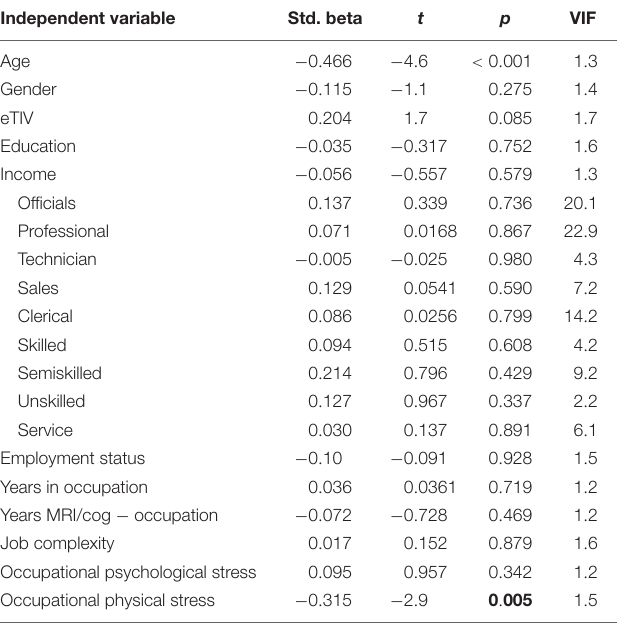
TABLE 3 | Occupational correlates of hippocampal volume.